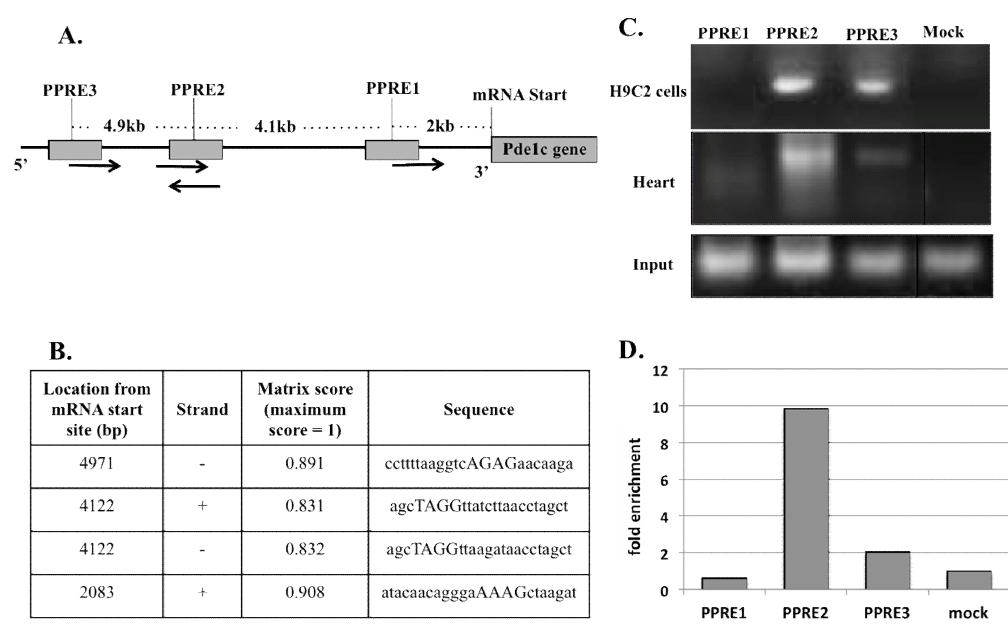
Figure 4. Chromatin immunoprecipitation assay of H9c2 cells and WT mouse heart genomic DNA revealed that PPAR α binds to two sites in the 5kb promoter region of Pde1C gene. ( A ) Schematic representation of 5kb Pde1C promoter region and locations of putative PPRE on the promoter. PPRE2 is a palindrome sequence. The arrows show plus and minus strands of DNA, respectively. ( B ) Specific locations and sequences of putative PPREs on Pde1C promoter as analyzed by Genomatix MatInspector software. ( C ) Total lysates from H9c2 cells and mouse heart treated with Wy-14,643 were analyzed by ChIP using PPARα antibody. PPARα bound to PPRE2 and PPRE3 in both H9c2 cells and WT mouse hearts. + and – refer to plus and minus strands of DNA, respectively. ( D ) ChIP of mouse heart was followed by RT-qPCR to quantify the extent of PPARα binding to Pde1C promoter. PPRE2 and PPRE3 showed 10- and 2-fold increased binding, respectively, as compared to mock. The input panel shown in Figure 4C belongs to that of heart samples. The input data of H9c2 samples not shown here are similar to that of heart samples.